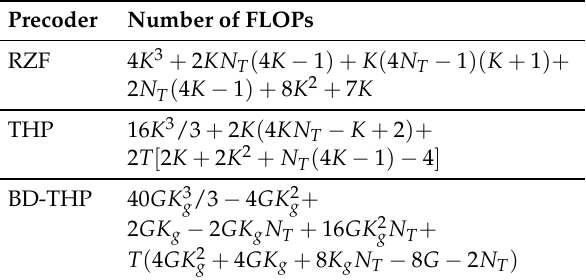
Table 1. Precoder’s complexity [3,13].